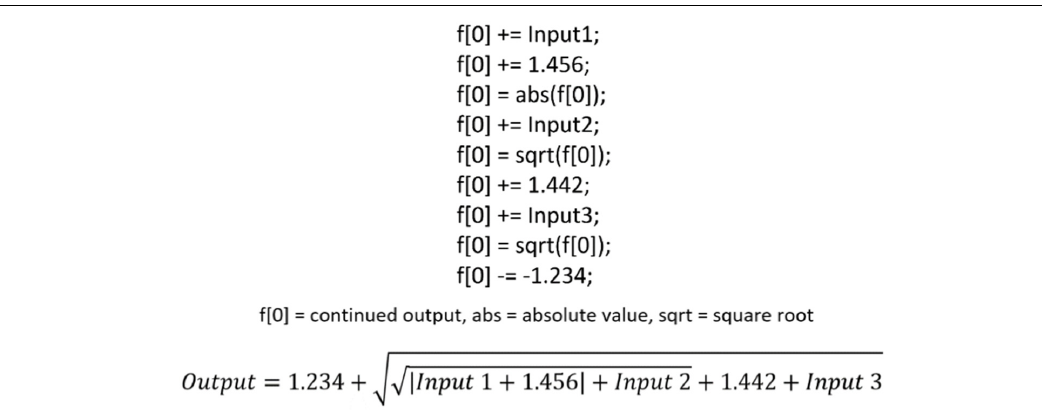
Algorithm 1. Example of simple LGP (Linear Genetic Programming), with corresponding algebraic